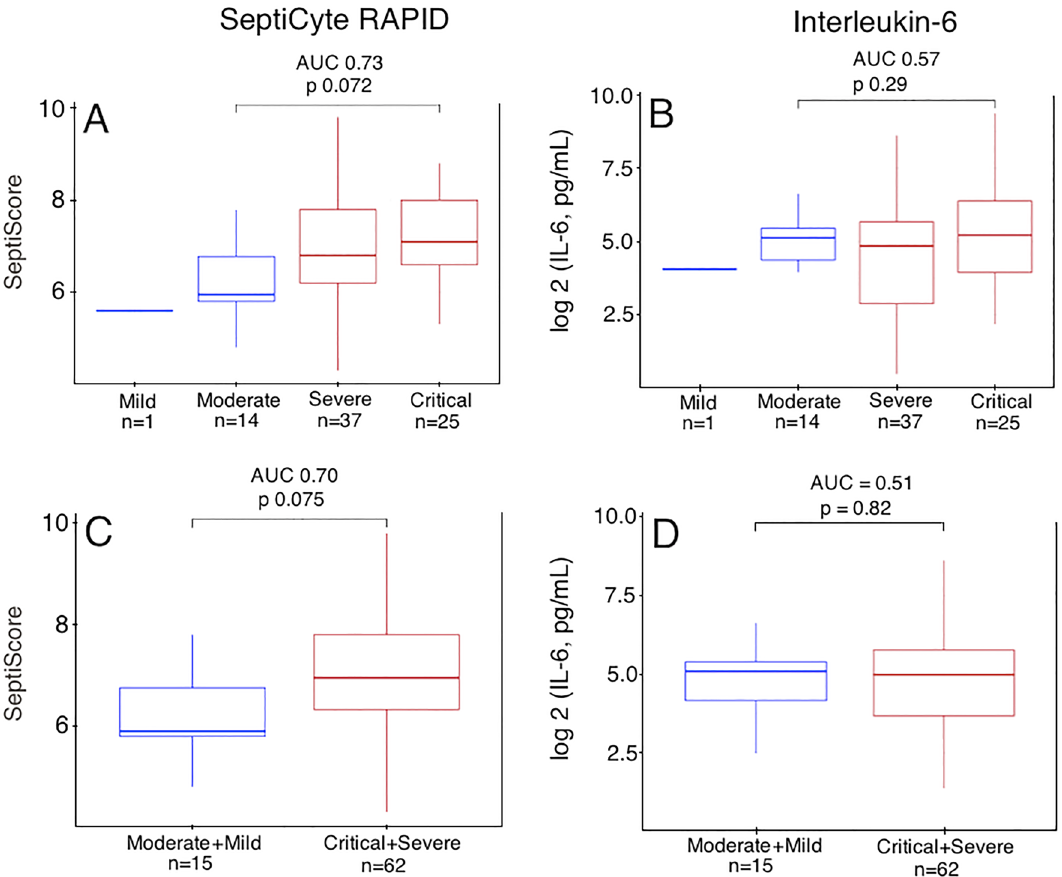
Figure 3. Performance of SeptiCyte RAPID relative to IL-6, in discriminating COVID severities. Panel A: distribution of SeptiScores across the different COVID severity classes (n = 77; only those patients who also had IL-6 measurements were considered). Panel B: IL-6 levels in pg/ml, log2 transformed, for patients across the same severity classes (n = 77; all available data). Panel C: SeptiCyte RAPID for mild + moderate grouped together, vs. critical + severe grouped together. Panel D: IL-6 for mild + moderate grouped together, vs. critical + severe grouped